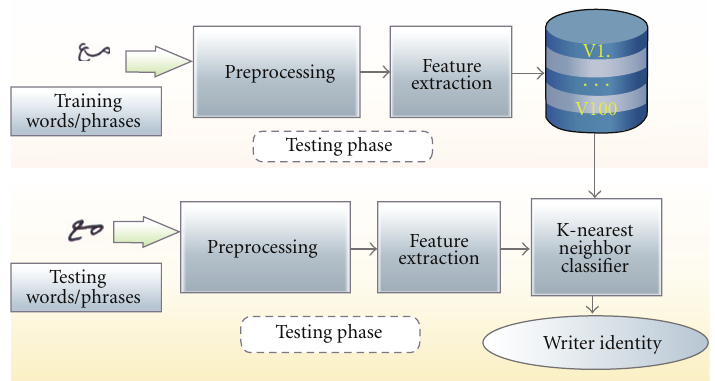
Figure 2: Training and testing phases in the text-dependent writer identification